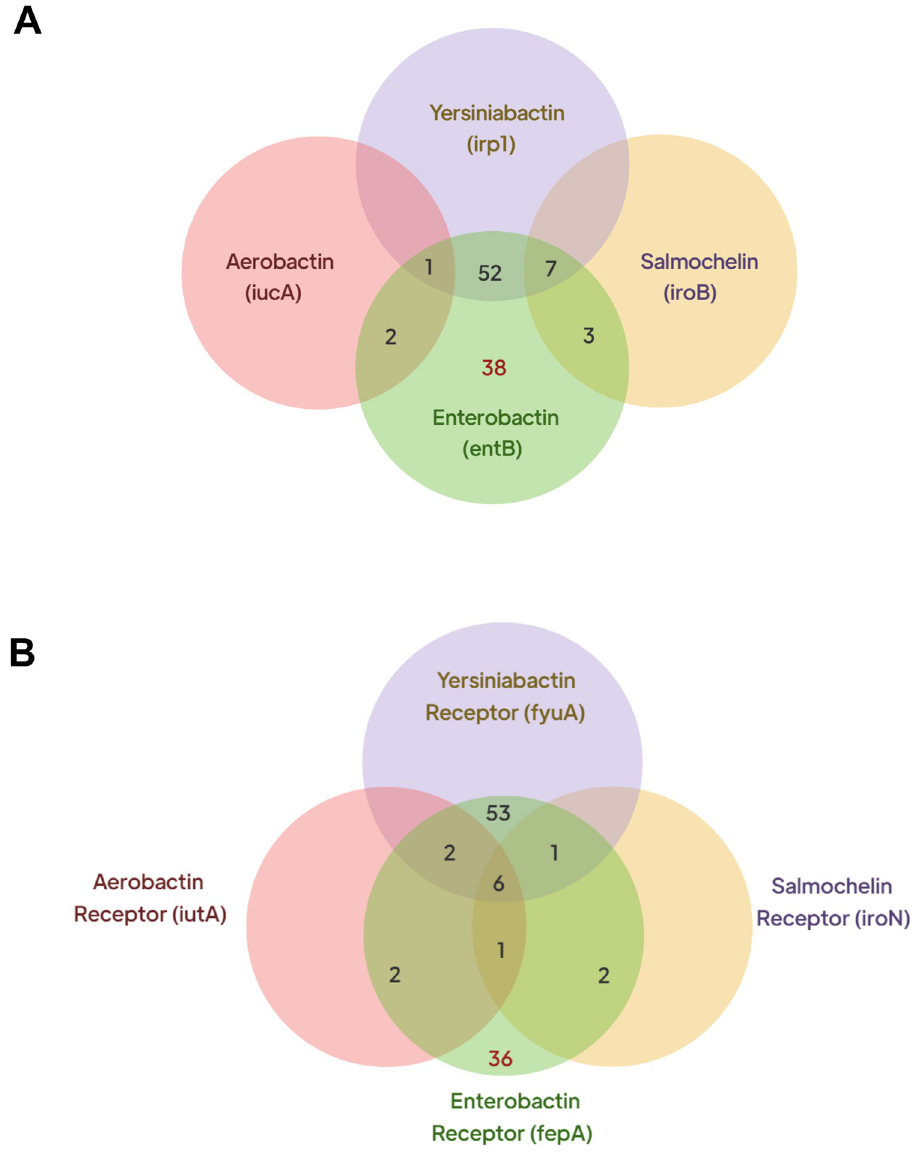
Fig 2. Venn diagrams for siderophore genes and their receptors. Four siderophore genes (A) and their receptors (B) were detected by PCR in 103 Klebsiella pneumoniae strains investigated in this study. The numbers shown represent the number of strains containing the